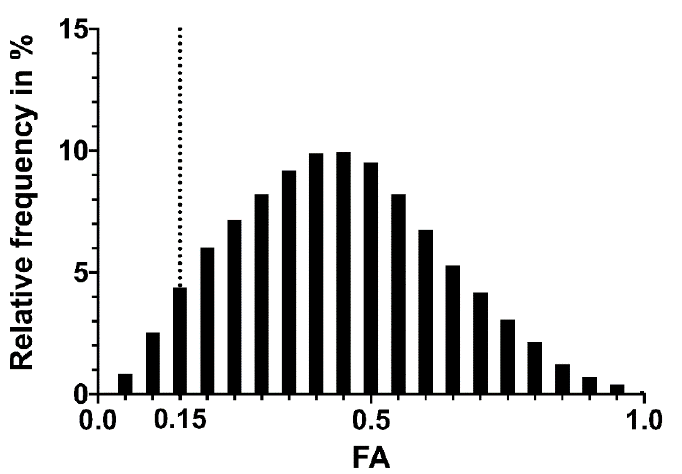
Figure 1. The frequency distribution of all fractional anisotropy (FA) values in our cohort (left, right, preop, and postop). Dotted line: 0.15. n = 293,921. The mean FA is 0.4406 ± 0.0003, the fifth percentile is 0.1454. The FA values are not normally distributed.